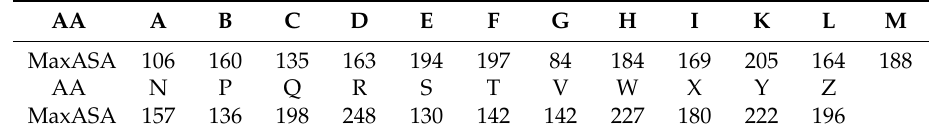
Table 1. Maximum accessible surface area (ASA) of different amino acids a